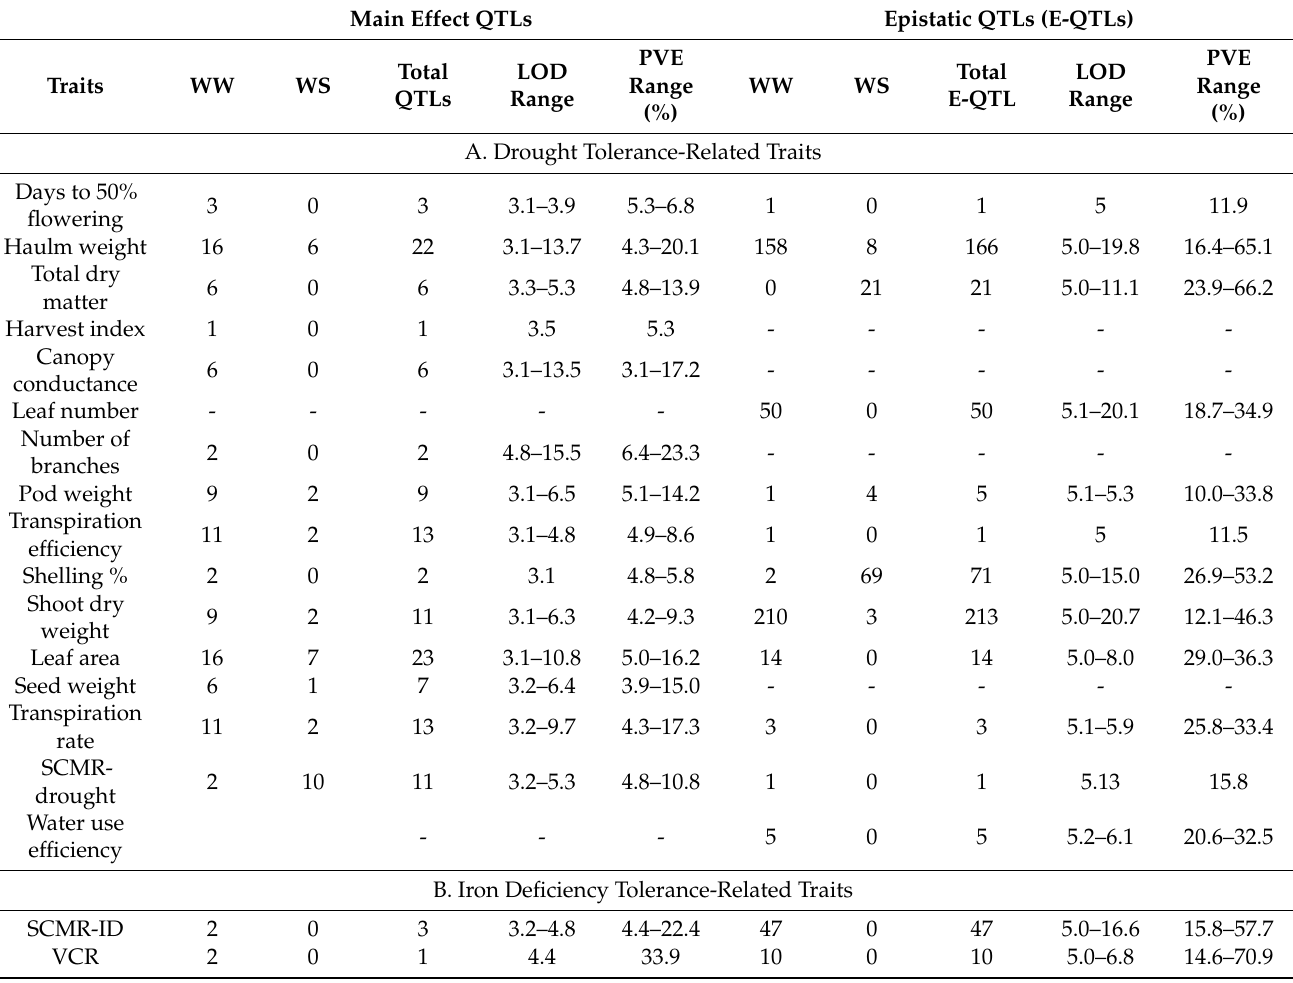
Table 3. Summary of main-effect and epistatic quantitative trait loci (QTLs) for drought tolerance-and iron deficiency tolerance-related